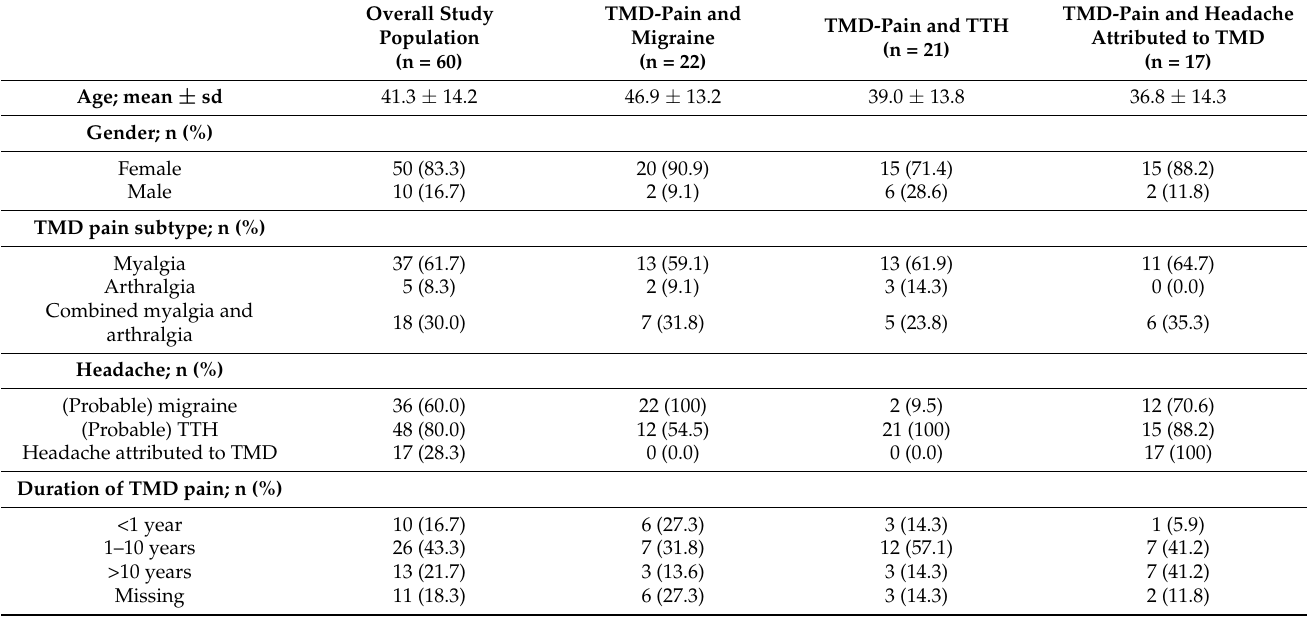
Table 1. Baseline demographic and diagnostic characteristics of the study